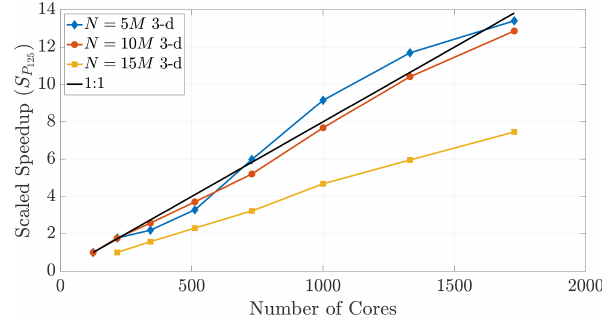
Figure 17. Speedup reference points of T 125 (and T 216 for the 15M run) result in super-linear speedup for only the N = 5M case, fur- ther exemplifying the disparity between 2-D and